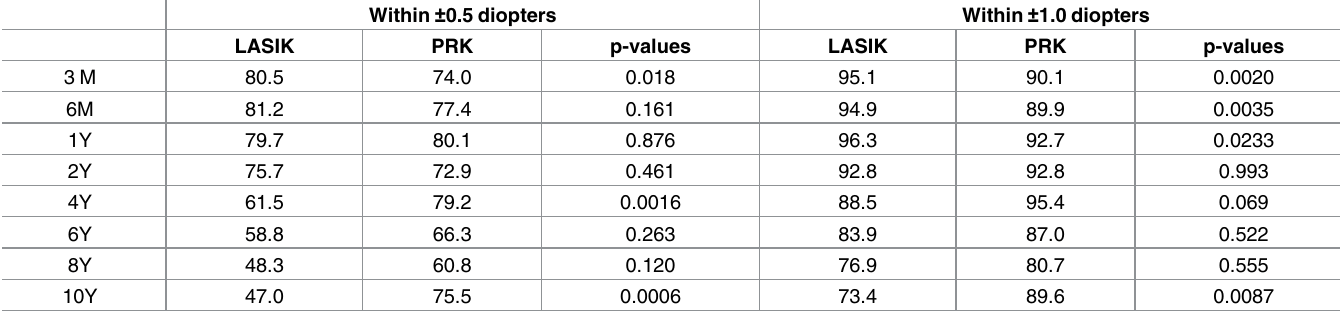
Table 3. Estimated percentages of eyes within ± 0.5 and ± 1.0 diopters. Within ± 0.5 diopters